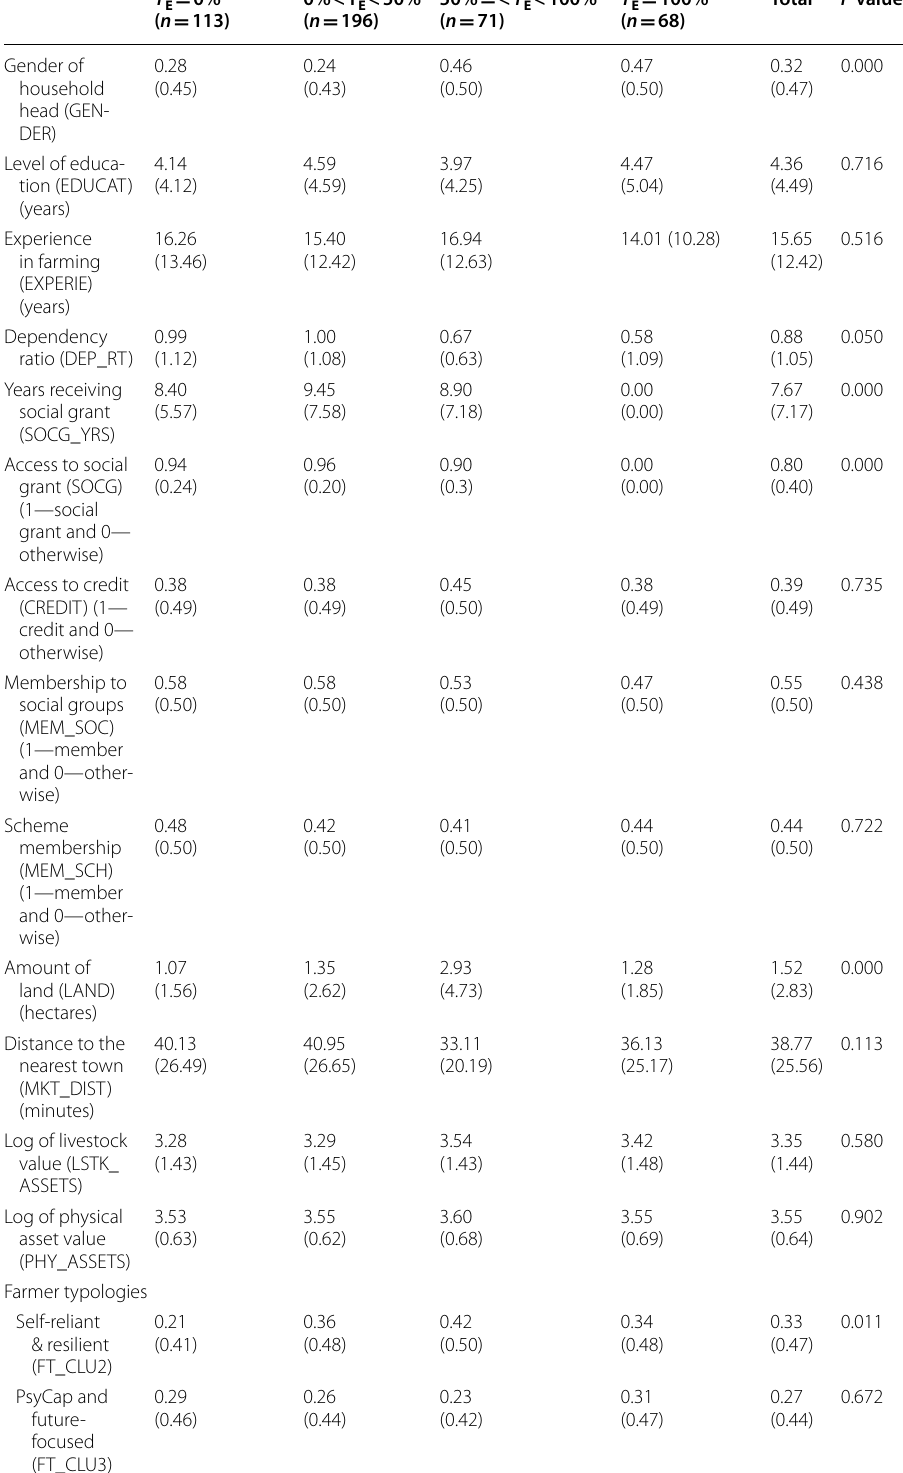
Table 4 Characteristics of sampled households by proportion of earned income. Source: Survey Data (April